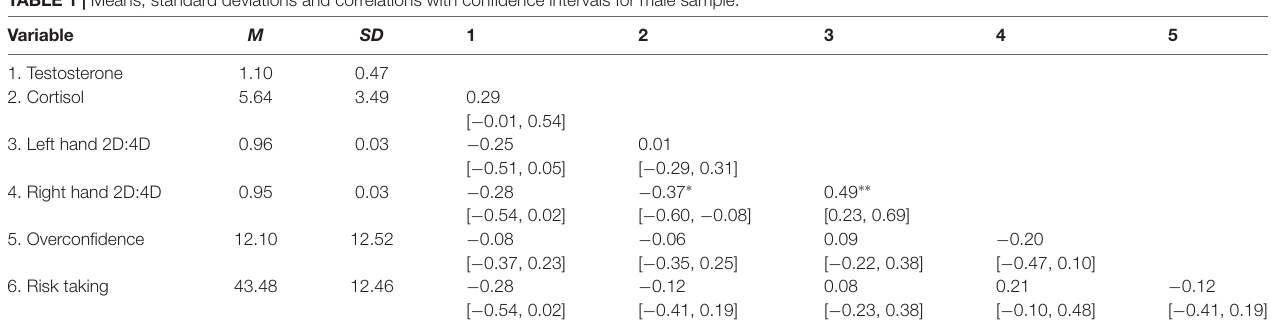
TABLE 1 | Means, standard deviations and correlations with confidence intervals for male sample. Variable M